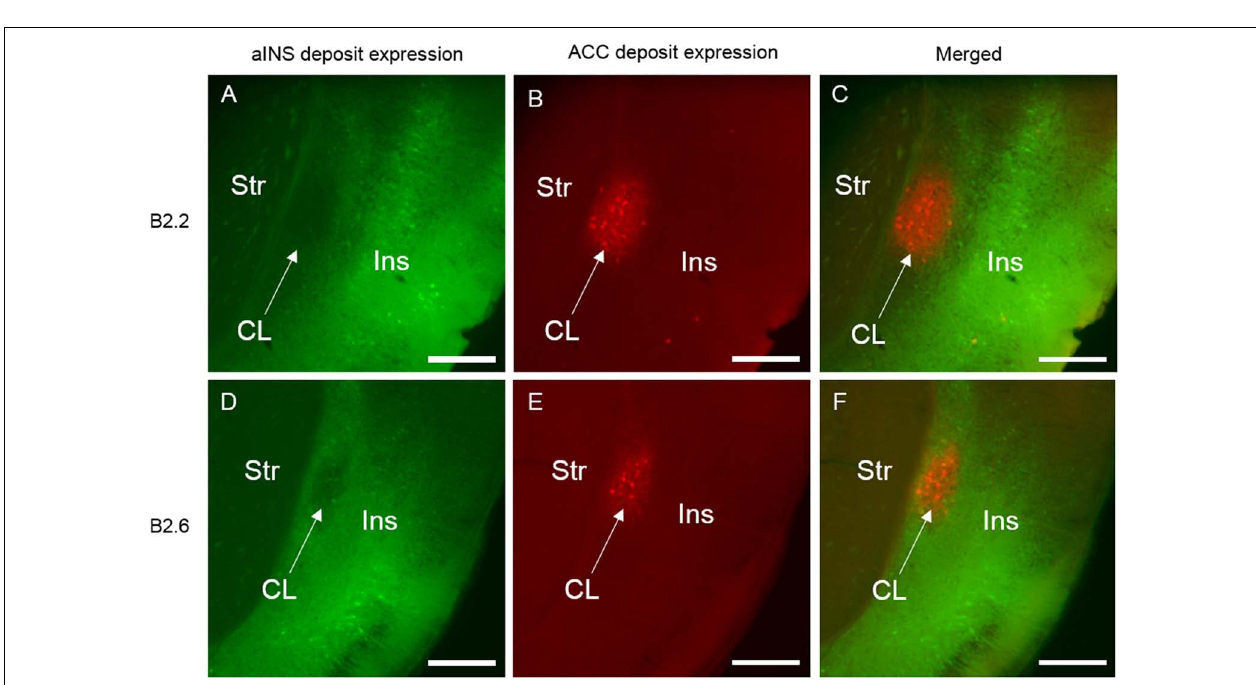
FIGURE 5 | Selected photomicrographs of the mid level of the claustrum and surrounding regions for case B2.2 (A–C) and B2.6 (D–F) (AP = + 0.50 mm from bregma), illustrating retrograde and anterograde labeling following aINS and ACC viral injections including surrounding regions. Merge of panels (A) and (B) is shown in (C) . Merge of (D) and (E) is shown in (F) . Scale bar: 500 µ m. Str, striatum; CL, claustrum; Ins, insular